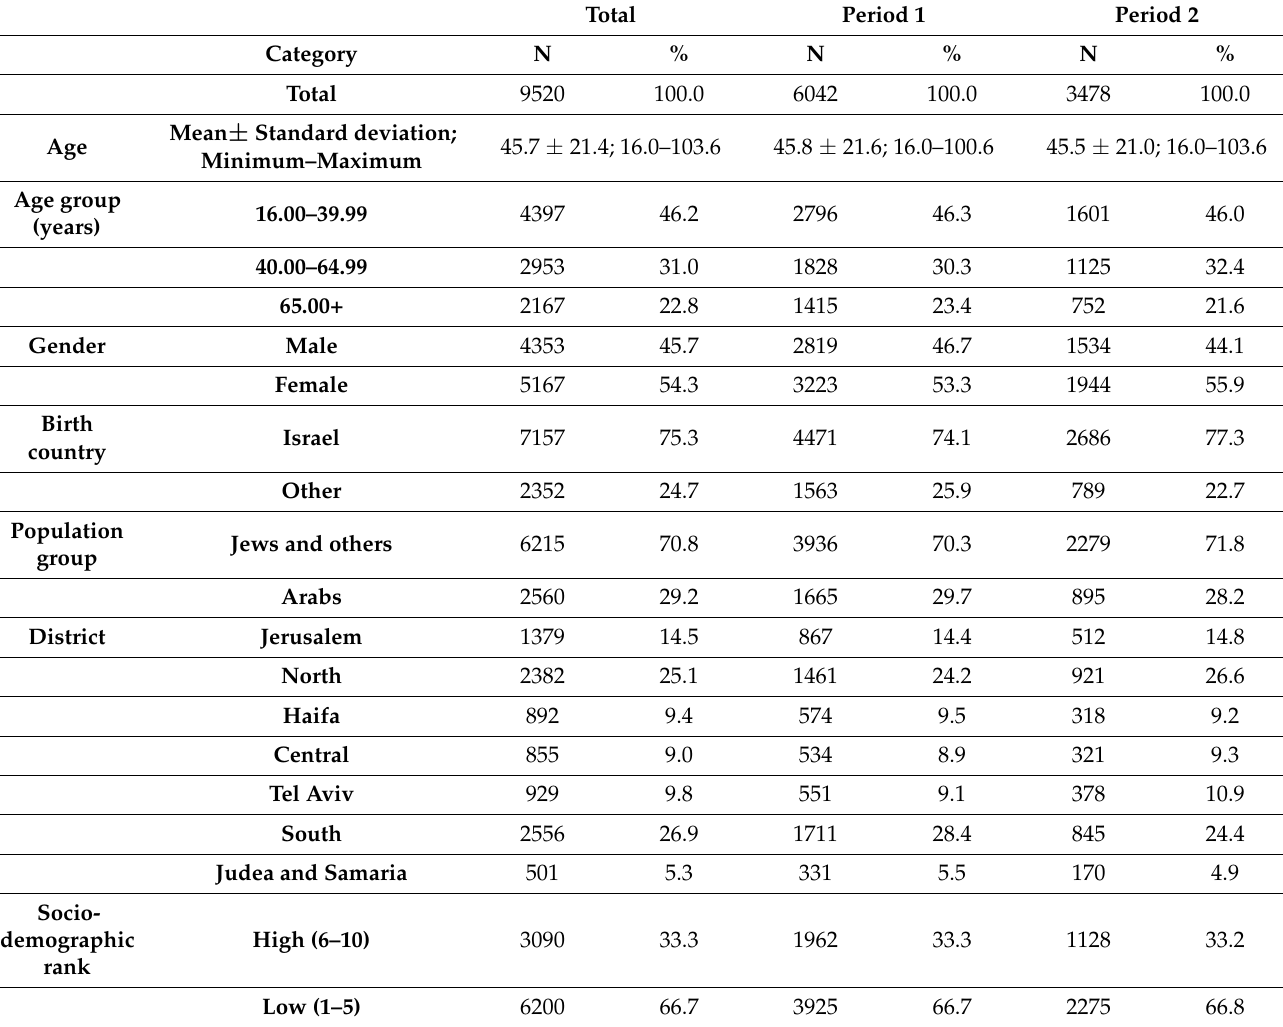
Figure 1 demonstrates seropositivity rates between January 2020 and July 2021 by